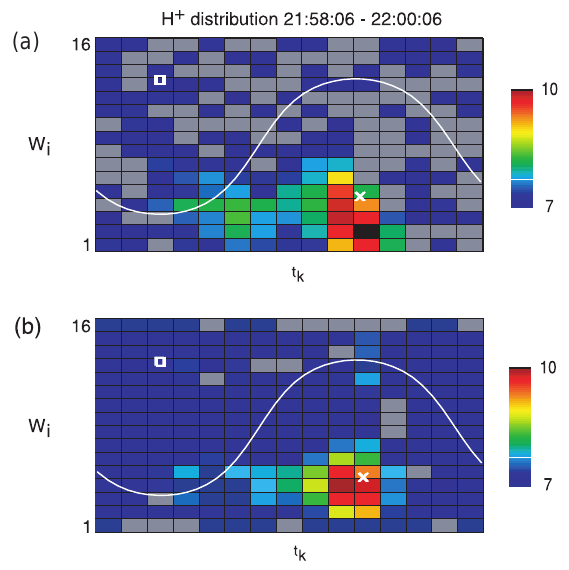
Fig. 9. An example of angular corrections: (a) H + angular dis- tribution observed between 21:58:06 and 22:00:06UT at measured energies ranging from 6.0 to 9.0eV, (b) the corresponding corrected